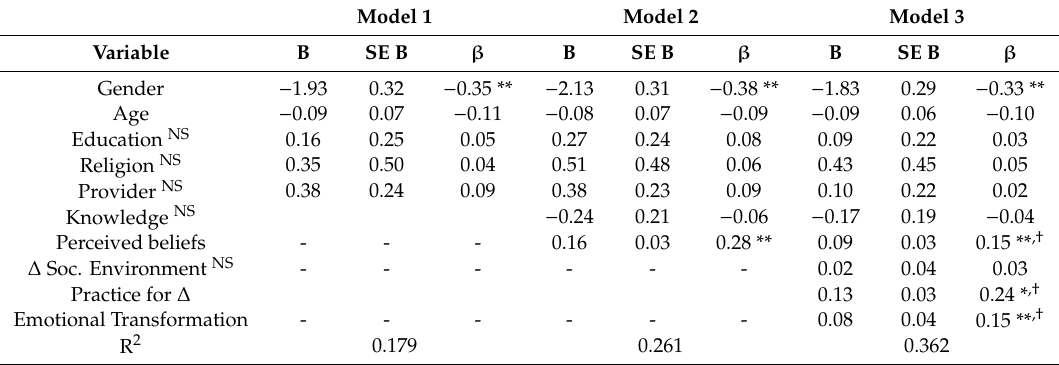
Table 4. Summary of hierarchical multiple regression analyses for covariates and MTM constructs predicting adolescents’ likelihood of completing the HPV vaccination series ( n =